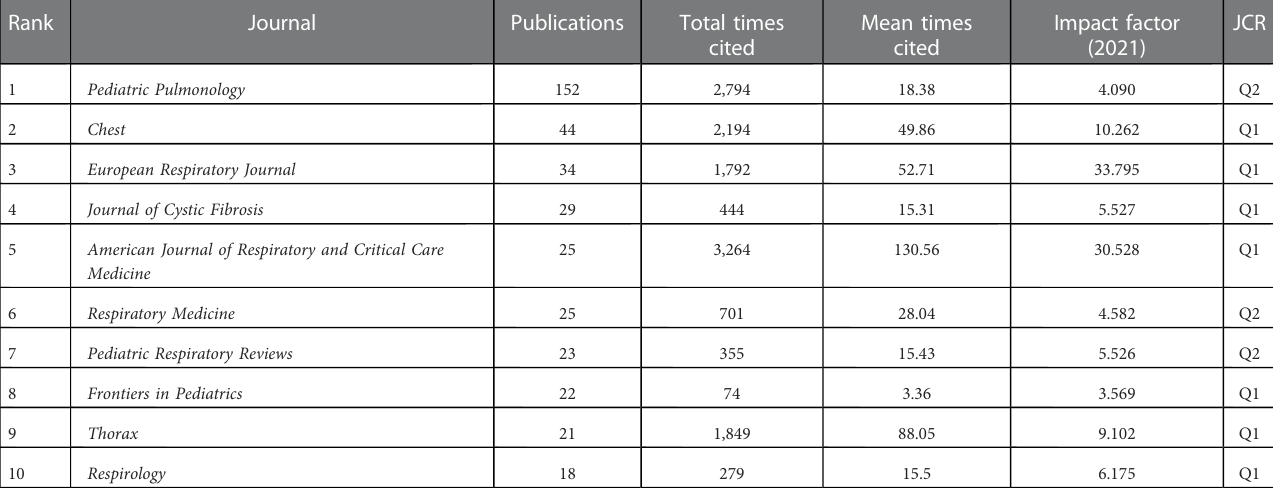
TABLE 2 Top 10 journals with publications related to bronchiectasis in children between 2003 and 2022.